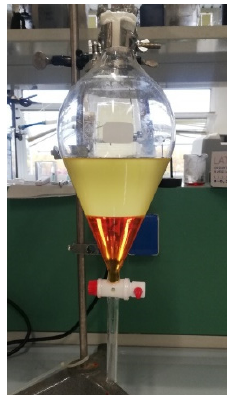
Figure 6. Separation of glycerol phase from biodiesel phase in a lab separating funnel.